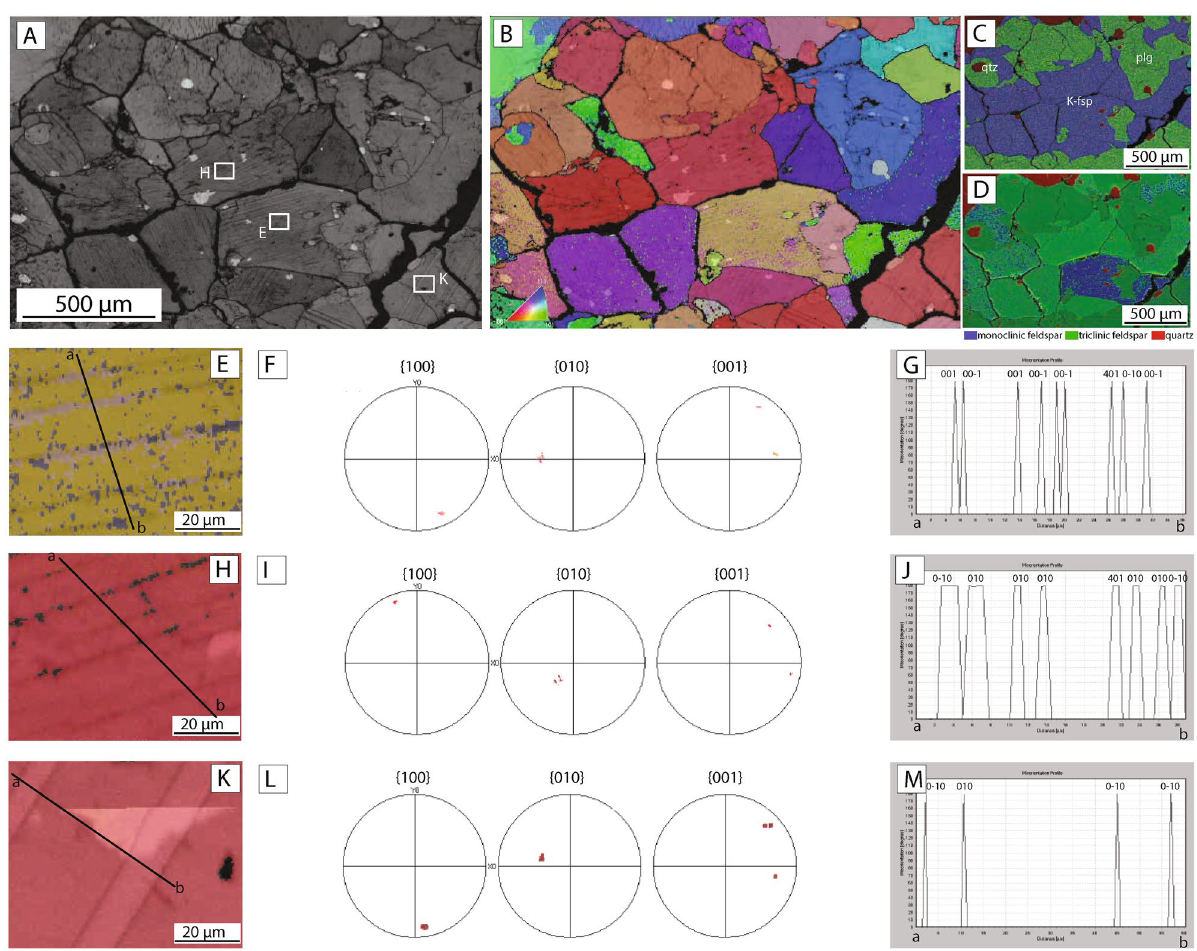
Figure 4. Crystallographic analysis of the surface fulgurite. (A) Band contrast image acquired during EBSD analysis. Note the presence of planar features in most of the K-feldspar grains (both monoclinic and triclinic K-feldspar (D) , but absence of planar features in the plagioclase (except for a few twins in the upper left corner). (B) Crystallographic orientation map colored according to the inverse pole figure color code for feldspar (inset). (C) EDS chemical map. Quartz is shown in red, plagioclase is green and K-feldspar is blue. (D) EBSD phase map shows the distribution of mineral phases in the sample. Quartz is shown in red, triclinic feldspar (Plagioclase) as well as triclinic K-feldspar is green and monoclinic feldspar (K-feldspar) is blue. Note that some K-feldspar grains have monoclinic crystal symmetry while others have a triclinic one. (E–M) Crystallographic analysis of a monoclinic K-feldspar (E–G) , a triclinic K-feldspar (H–J) , a triclinic Plagioclase (K–M) . The locations of the analysis are indicated in image (A) . (E,H,K) Orientation map overlaid on band contrast image. Black line shows the location of the misorientation profile shown in (G,J,M) . (F,I,L) Pole figure (upper hemisphere) shows the orientation of (100), (010) and (001) axes of the crystals. (G,J,M) Misorientation profile across the examined grains shows the rotation angle and rotation